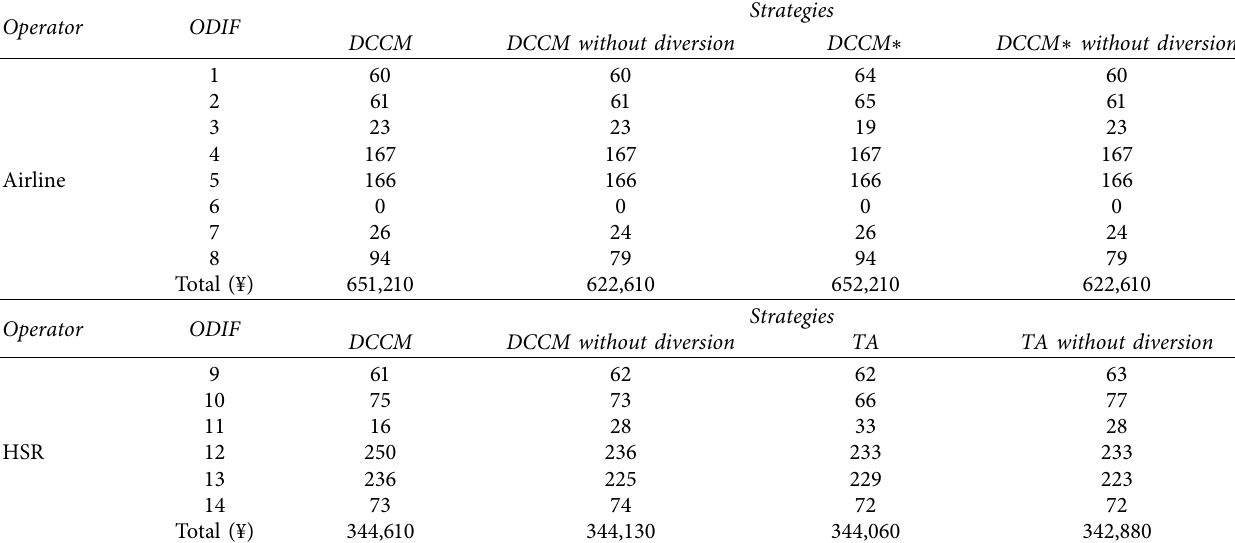
Table 9: Revenue comparison with and without demand diversion.